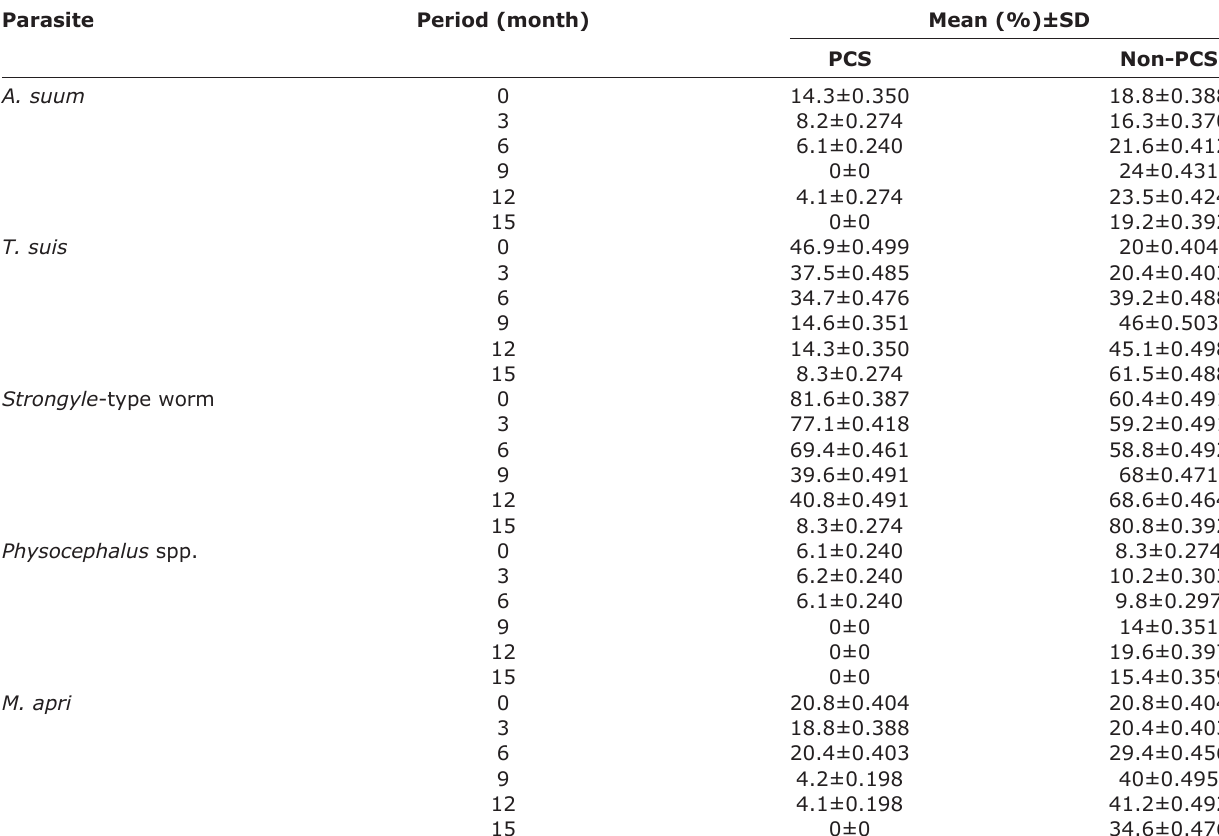
Table-1: Prevalence of parasites infection in confinement and non-confinement pigs during the monitoring period. Parasite